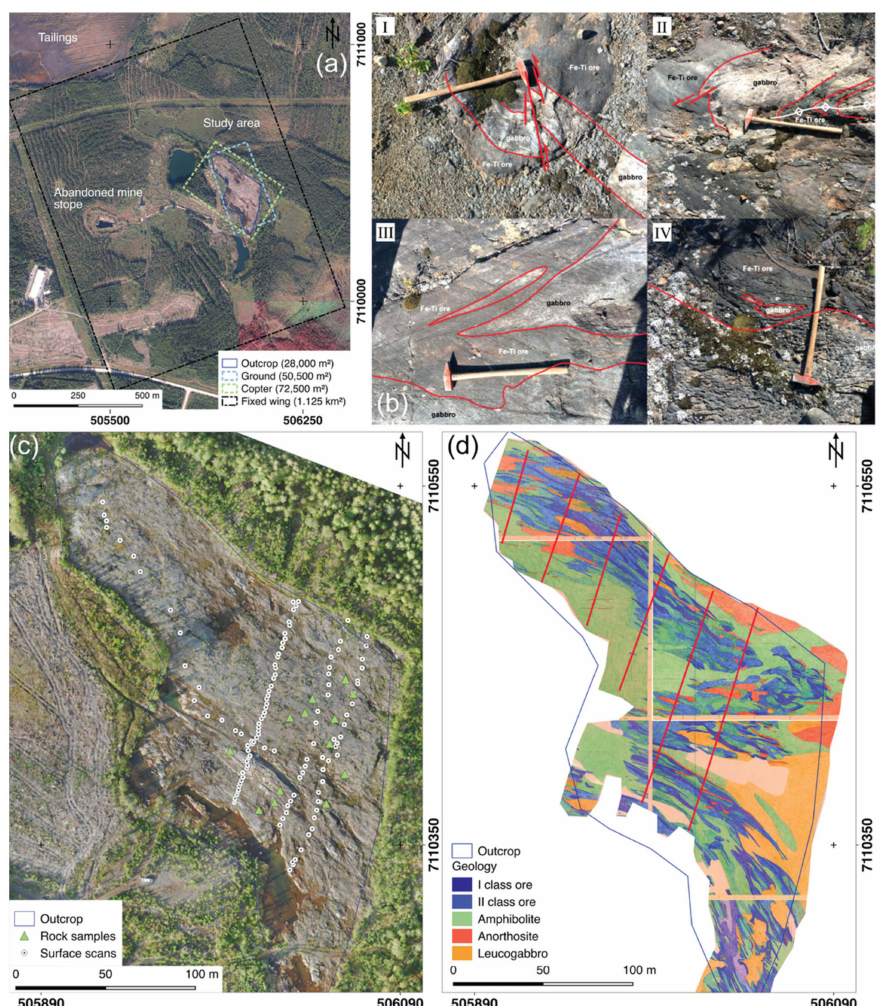
Figure 2. ( a ) Location of the study area at Otanmäki, central Finland. Rectangles outline the areas of the di ff erent magnetic surveys. ( b ) Photos (I–IV) from the surface of the Metsämalmi outcrop show magnetite-ilmenite ore lenses and host rock (gabbro). Hammer handle length for scale is ~1 m. ( c ) UAS-borne orthophoto shows sampling locations at the Metsämalmi outcrop. ( d ) Geologic map from Metsämalmi that is provided by company Otanmäki Mine Oy (modified). Larger parts of the outcropping area are mapped as high grade (Class I) ore that contains 60–70% of magnetite and ilmenite. Red lines indicate surface measurements (i.e., magnetic susceptibilities along scan lines) performed by Otanmäki Mine